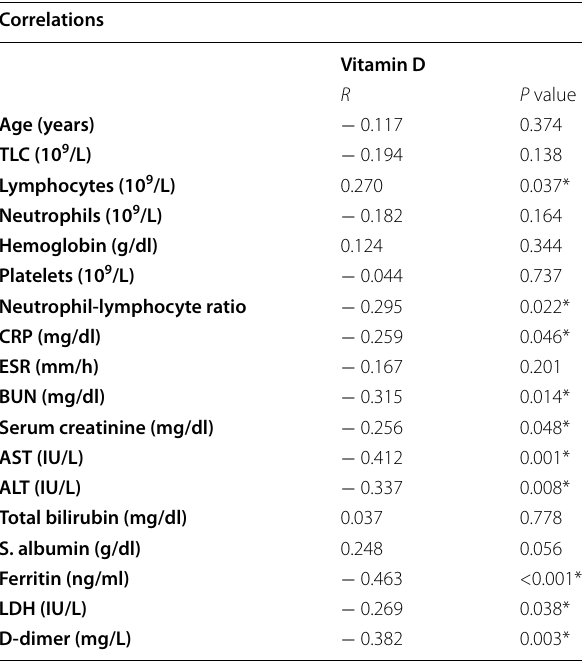
Table 4 Correlation of vitamin D and age, different laboratory, and radiologic findings of COVID-19